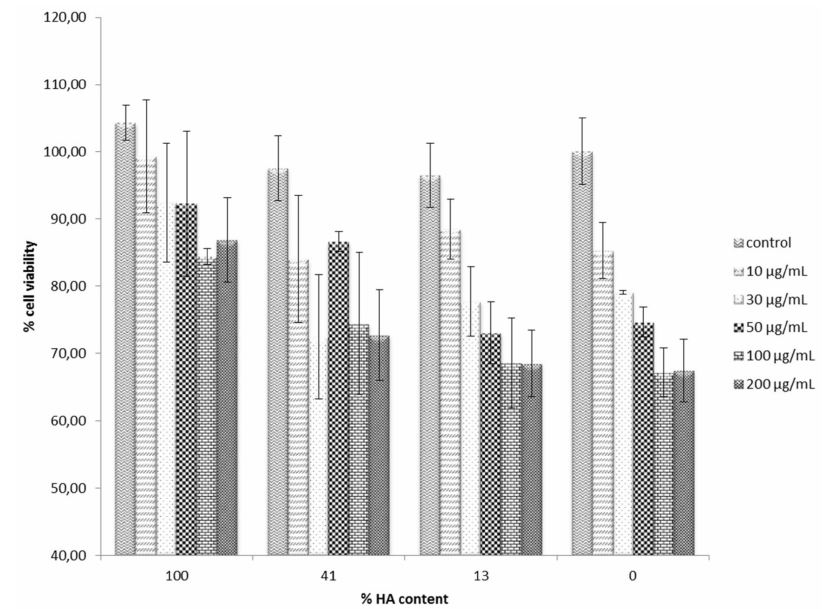
Figure 6. The effect of curcumin-loaded β -TCP, HA and biphasic samples on MG-63 cell viability and proliferation. Cells were treated with 10, 30, 50, 100 and 200 µ g/mL of each bone graft. The results are presented as mean ± standard deviation (SD) of three independent